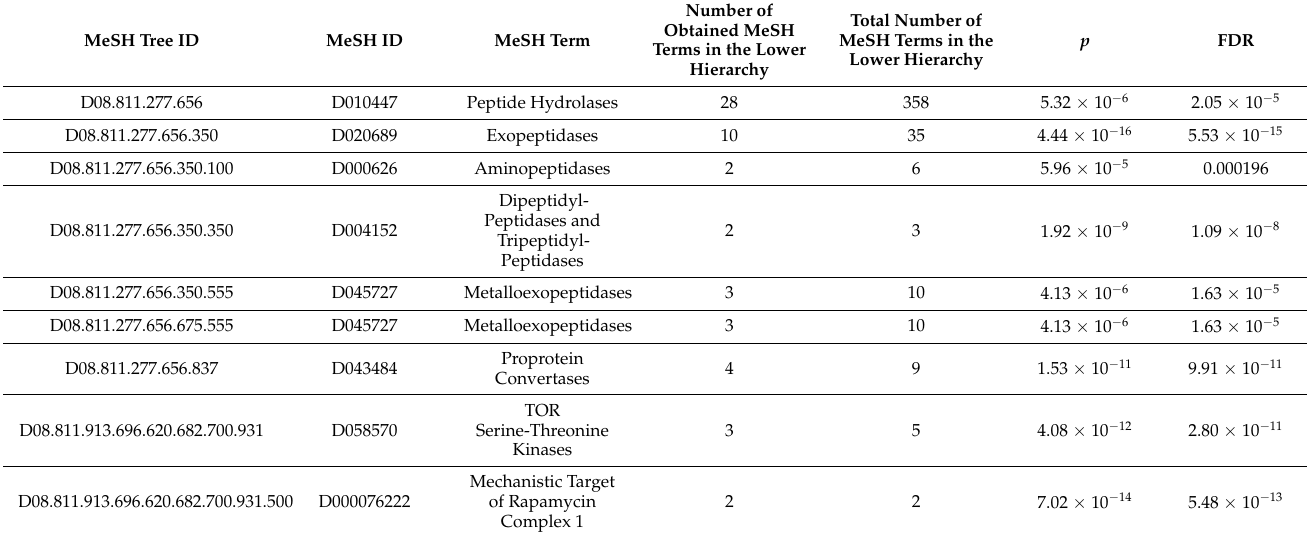
Table 3. MeSH terms under the enzyme (D08.811) in the over-representation analysis of the 291 MeSH terms obtained from “Leucine” and “Diabetes Mellitus, Type 2” at a false discovery rate (FDR) level of <0.01 (1)